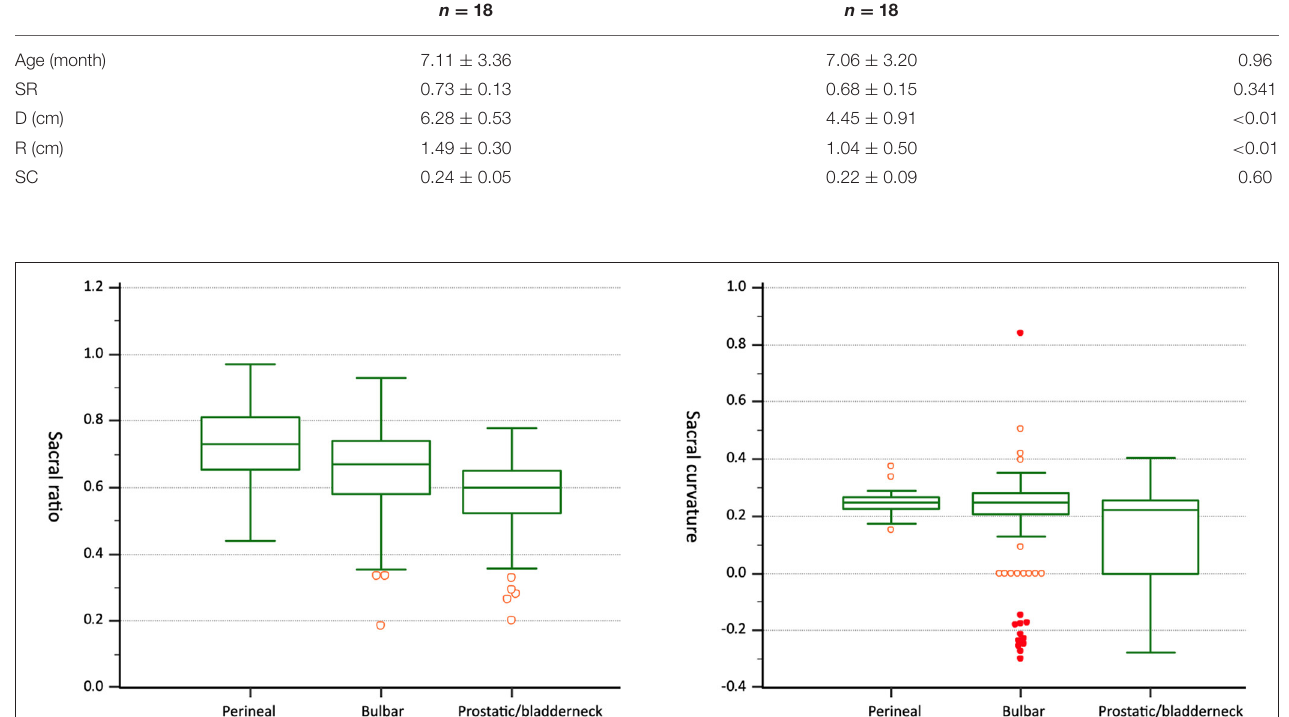
TABLE 2 | Age-matching comparison between perineal and bulbar fistulae. Perineal Bulbar